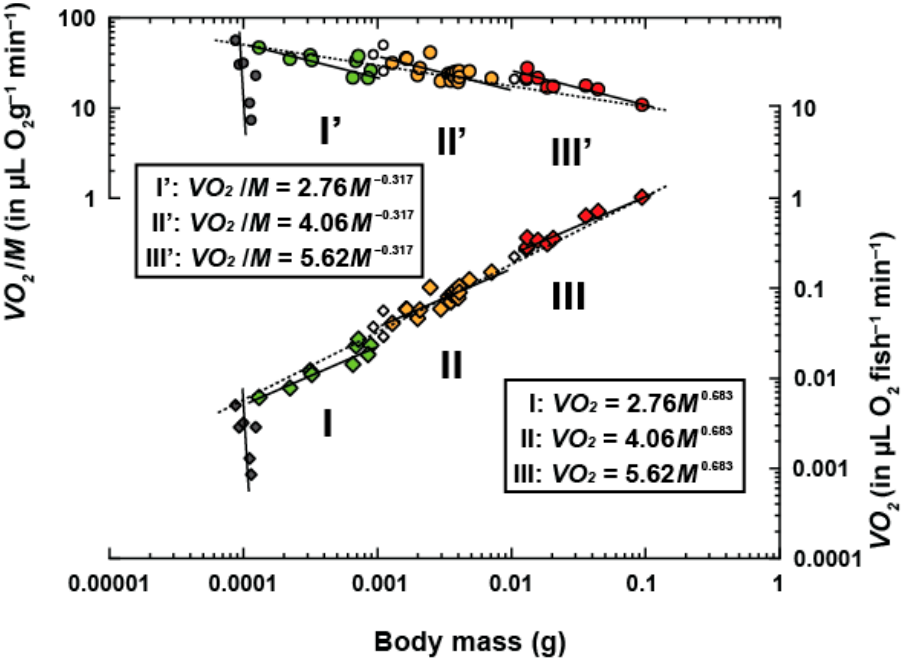
Figure 2. Ontogenetic changes in the relationship between the rate of respiration ( VO 2 , diamonds) and body weigth ( M ) in the Japanese anchovy at 25 ◦ C using the micro-semi-closed method. Ranges covered by the three solid black lines for VO 2 and VO 2 / M indicate intragroup phases of negative allometry. The vertical lines at around 0.0001 g represent VO 2 , which increased daily from just after hatching to 43 days after hatching. Small open diamonds and circles represent values during the transitional phases. Table 2. Intragroup (rows 1–3) and intergroup (rows 4–6) regression analyses for the relationship between logVO 2 ( VO 2 equals the total oxygen consumption in µ L O 2 fish − 1 min − 1 ) and logVO 2 ( M , body weight in g) using the micro-semi-closed